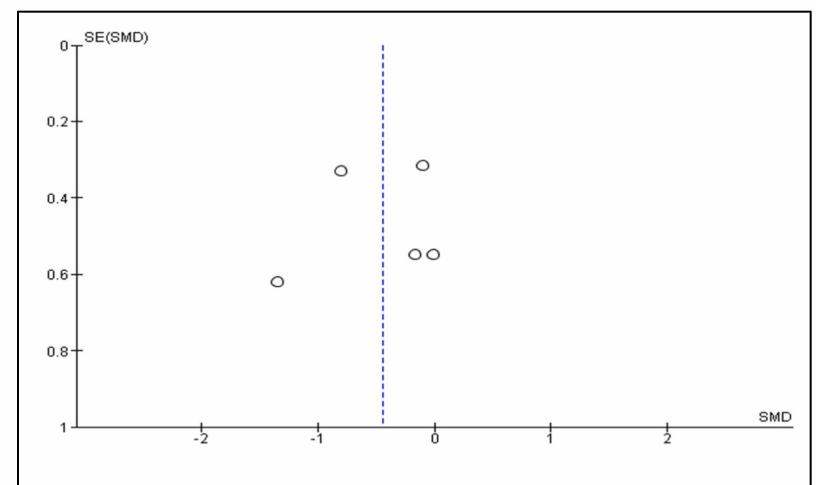
Figure 11. Funnel plot summary for secondary outcome quantitative pain reduction assessment (VAS score) from baseline up to the final follow-up